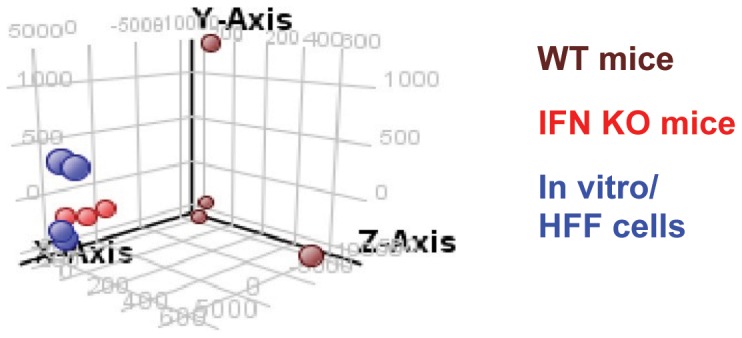
Genome wide expression analysis indicates a significant difference between parasites isolated from WT mice compared to those grown in vitro in HFF cells and in vivo in IFN KO mice.Principal component analysis of replicate samples of parasites grown in vitro in HFF cells compared to in vivo in WT mice or IFN KO mice. Principle component analysis (PCA) captures the variation across samples using a limited number of parameters to estimate sample to sample differences. In this study the first principle component (X-axis) captures 73.47 percent of the variance. Y and the Z axis show two minor trends which represent 5.38 and 2.8 percent variance respectively.